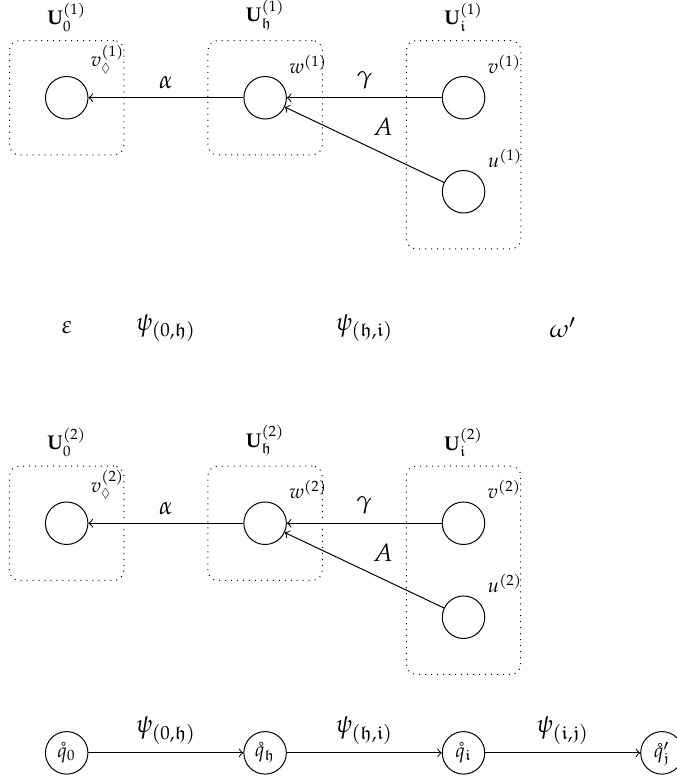
Figure 23. The relevant part of Γ p 1 q after the reduce action is performed by the character-level RNGLR and the corresponding part of Γ p 2 q after the reduce action is performed by our